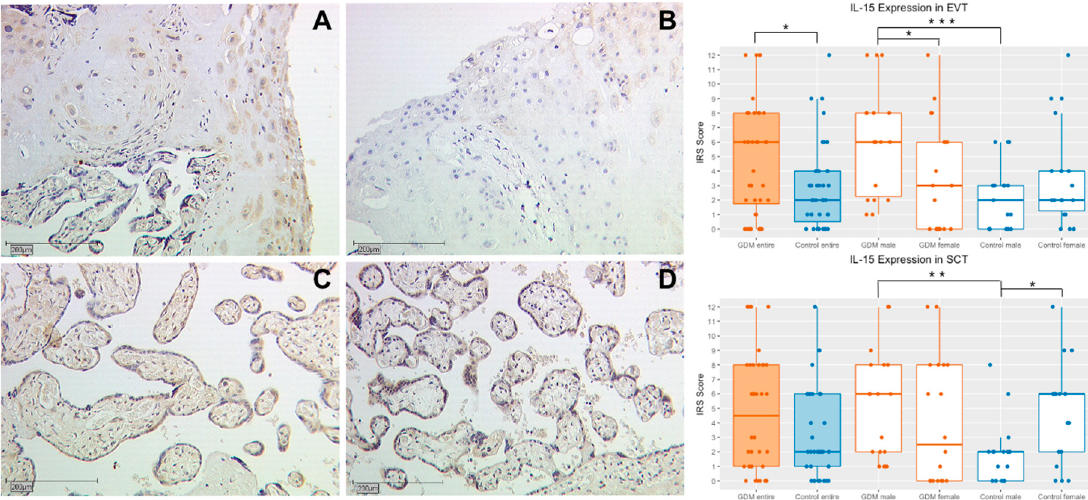
Figure 3. Representative immunohistochemical staining for IL-15 in EVT in placentas of women with GDM and the control group at a magnification of 10×. Staining of the EVT in a placenta with GDM is shown in image ( A ) and of the control group in image ( B ). IL-15 expression of the SCT in placentas with GDM is demonstrated in image ( C ) and of the control group in image D . The quantification of the IL-15 expression in placentas (with use of the IRS) of the study and control group and also their subgroups is shown in the box plots. Orange boxes represent the GDM group and blue boxes the control group. The range within the boxes represents the values between the 25th and 75th percentile with a horizontal line at the median. The T-bars extend 1.5 times of the interquartile range, or if no value is in that range, to the minimum or maximum value. The dots are marking the value of each data point. Significant results are linked with lines and marked with an asterisk ( p < 0.05: *; p < 0.01: **; p < 0.001: